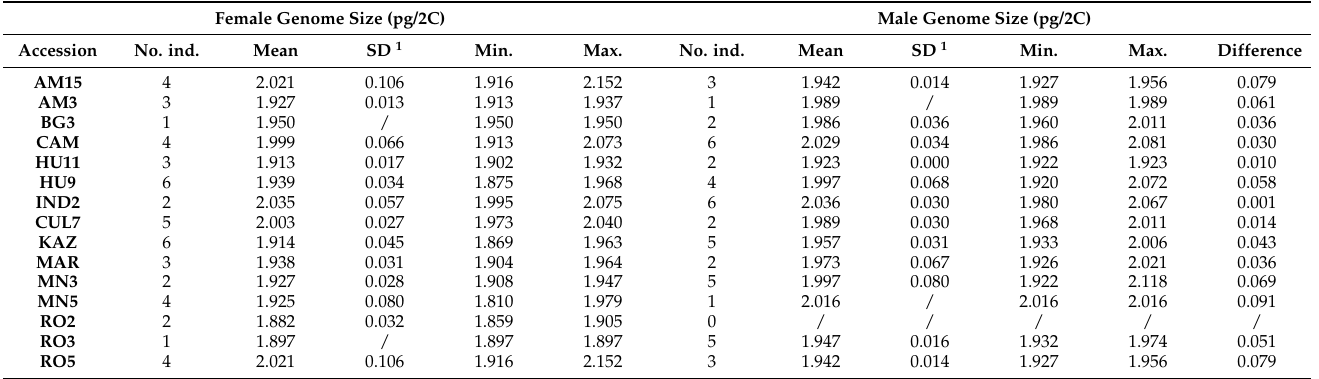
Table 2. Differences in genome size between male and female individuals in the 15 selected Cannabis accessions. More details of the accessions can be found in the Supplementary Table (Table S1). Female Genome Size (pg/2C) Male Genome Size